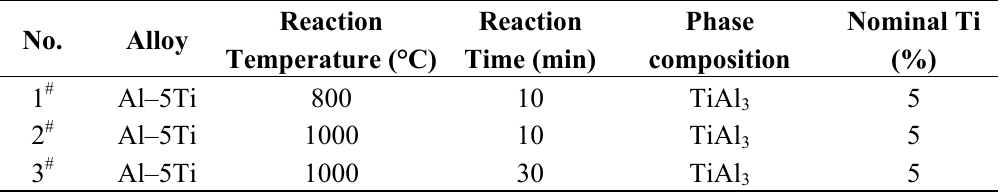
Table 2. The synthesis parameters and composition of Al–5Ti master